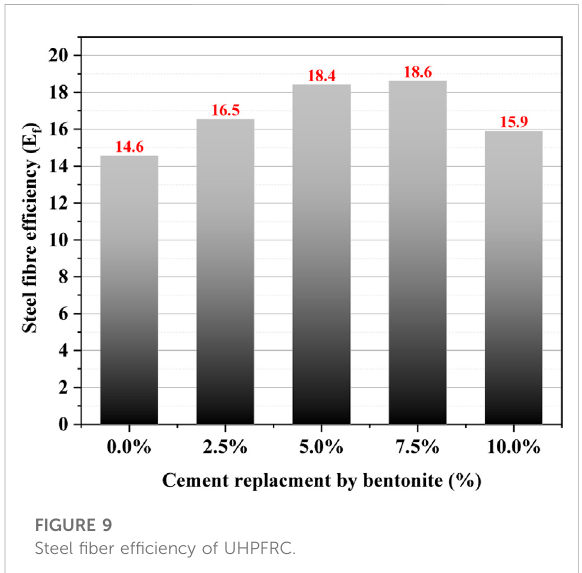
FIGURE 9 Steel fi ber ef fi ciency of